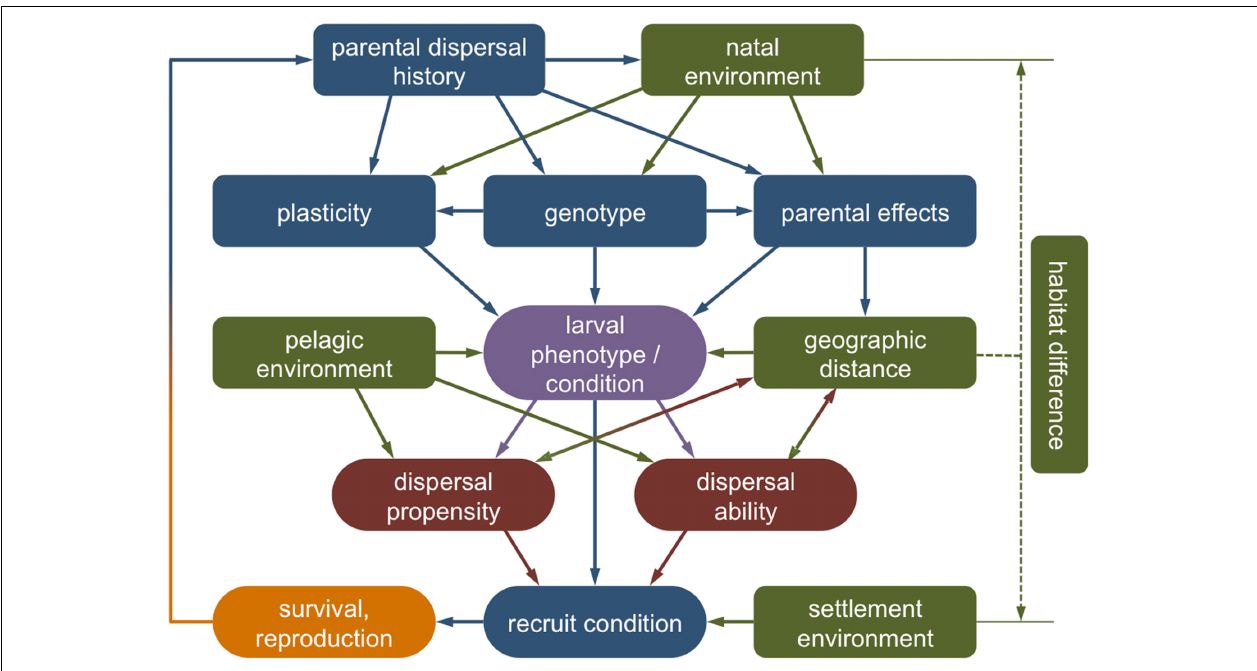
FIGURE 4 | Theoretical framework outlining the causes and consequences of larval dispersal polymorphisms. Intrinsically, the phenotype and condition of a dispersing larva (purple) will be the product of its genotype, plasticity toward environmental variation and parental effects, which in turn are affected by parental history (blue). Extrinsically, the larval phenotype is affected by external conditions experienced in the natal and the dispersal environment (green). The interaction of environmental